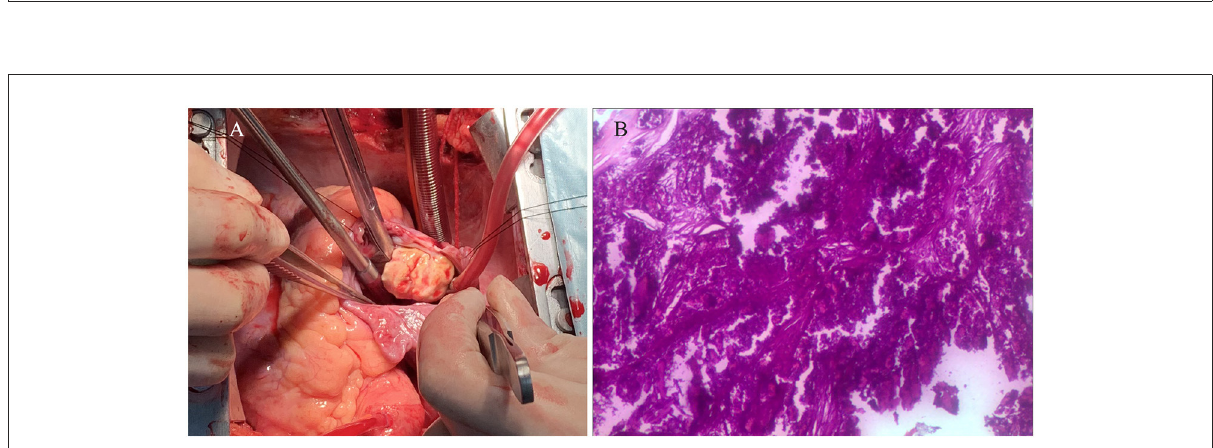
FIGURE4 (A) The intraoperative image showed that the mass, with a firm-hard texture, was confirmed to be partially embedded in the right atrium. (B) The histopathological examination revealed that the mass consisted of abundant calcific deposits without malignant